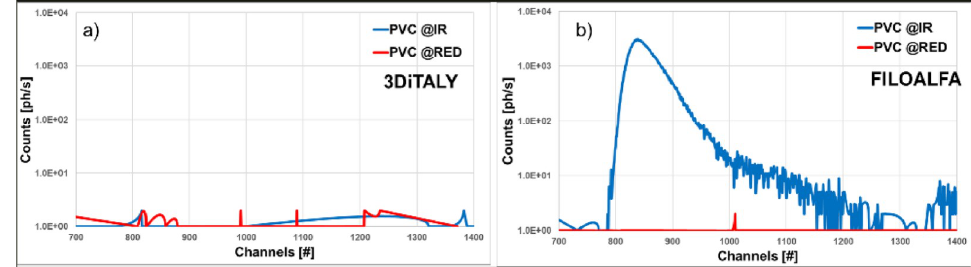
Fig 7. TD-NIRS signals obtained with the two 3D printed probes tested on the PVC surface at 689 nm (RED) and 828 nm (IR). In panel a) results are shown for probe printed with black 3DiTALY filament; in panel b) for probe printed with black FILOALFA